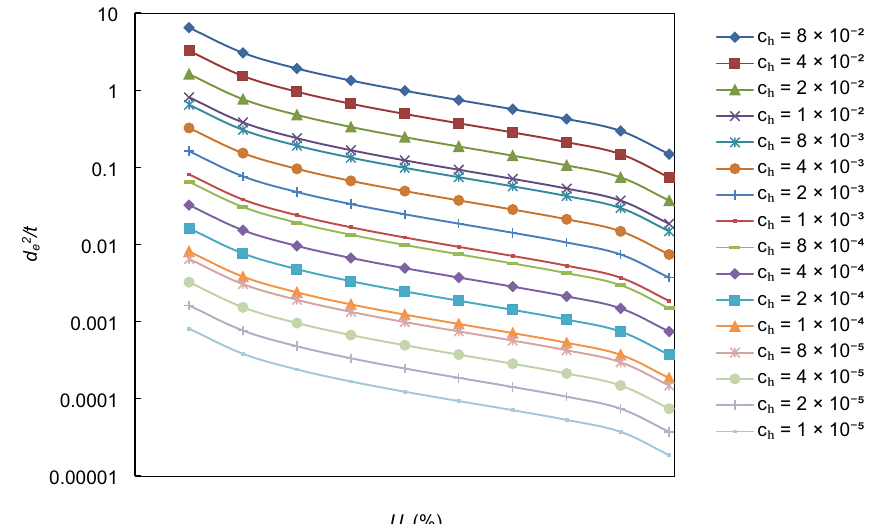
Fig. 3 Theoretical log 10 ( d e 2 / t ) versus U r curve for different values of c h (Graph from Sridharan et al.